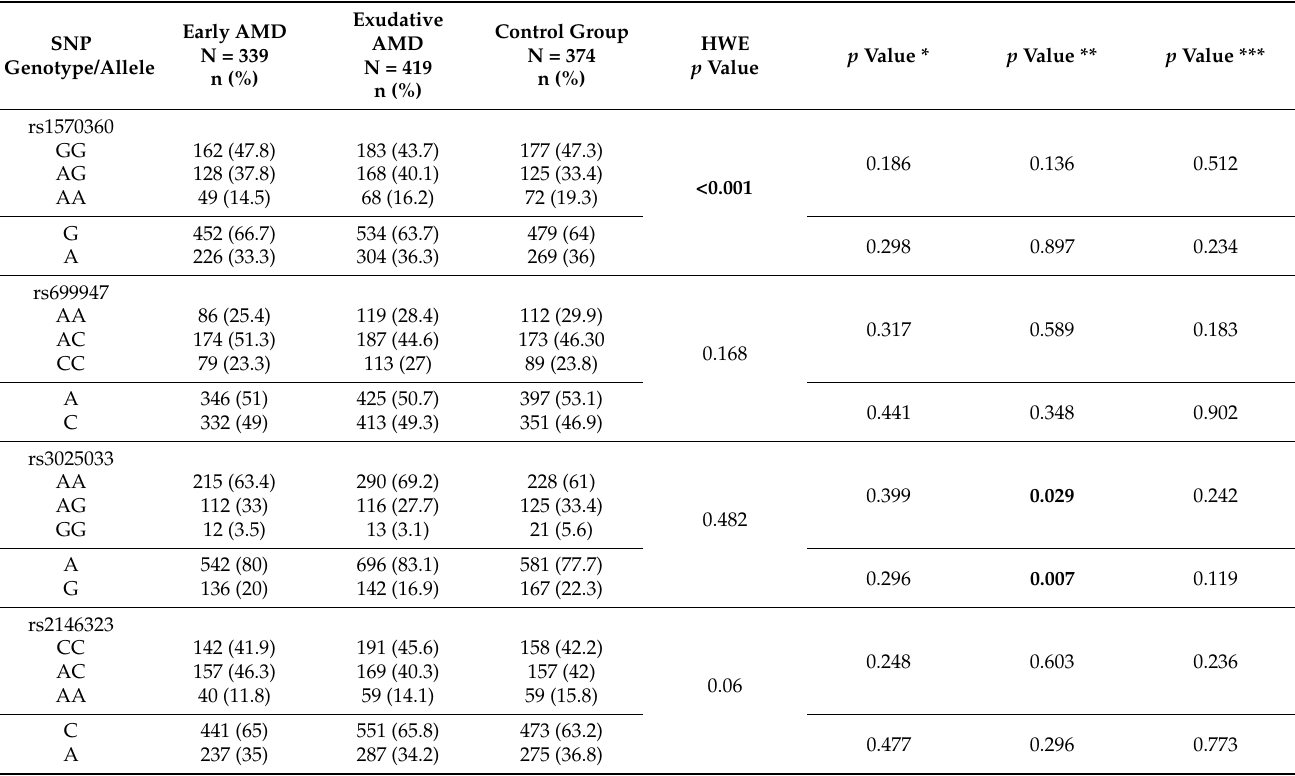
Table 2. Frequencies of VEGFA (rs1570360, rs699947, rs3025033, and rs2146323) genotypes and alleles in early AMD, exudative AMD, and control groups.